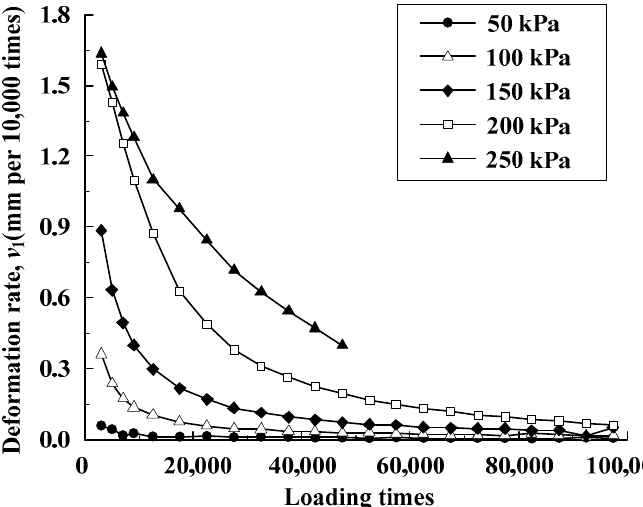
Figure 9. Deformation rate against loading times for Model 1 ( K = 0.9).